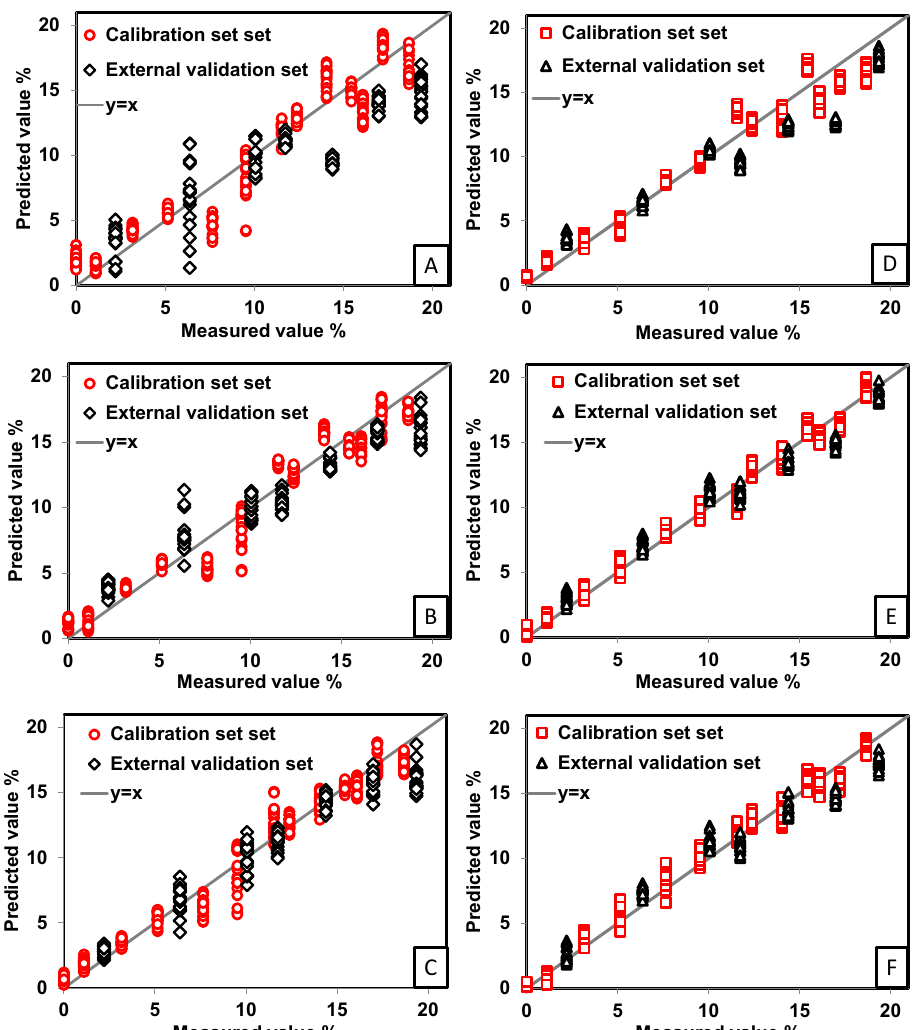
Figure 6. PLS regressions obtained for the measured API values in % w/w versus the predicted IBU values in % w/w for the calibration set and the external validation set. ( A ) API prediction in tablets with no preprocessing; ( B ) API prediction in tablets with SNV preprocessing; ( C ) API prediction in tablets with SG-1D + SNV preprocessing; ( D ) API prediction in powder blends with no preprocessing; ( E ) API prediction in powder blends with SNV preprocessing; and ( F ) API prediction in powders blend with SNV + MSC preprocessing. Table 3. Multivariate analysis results obtained for QCL–PLS models by using individual diodes.